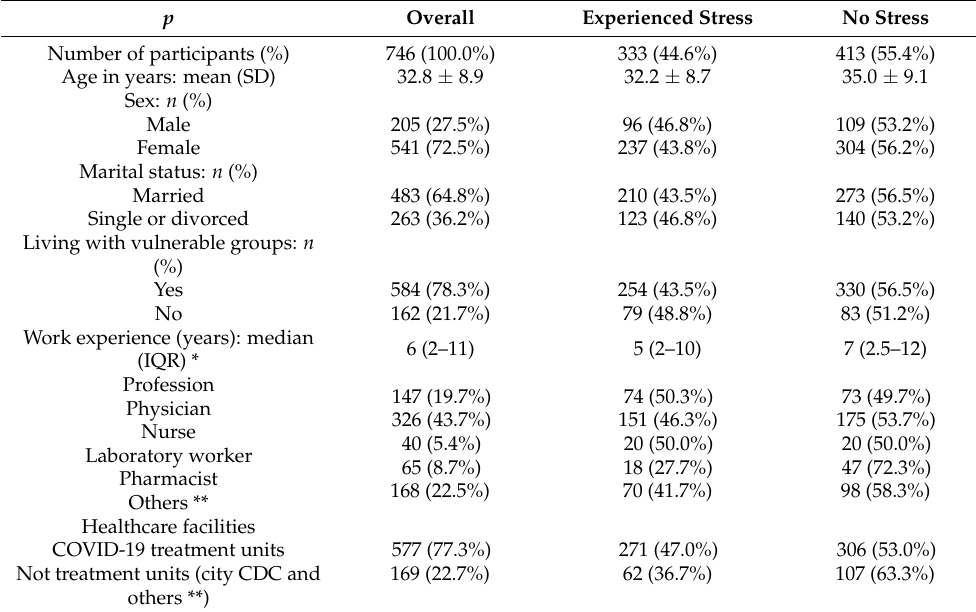
Table 1. Demographic and occupational characteristics of healthcare workers grouped by the reported stress levels ( n =